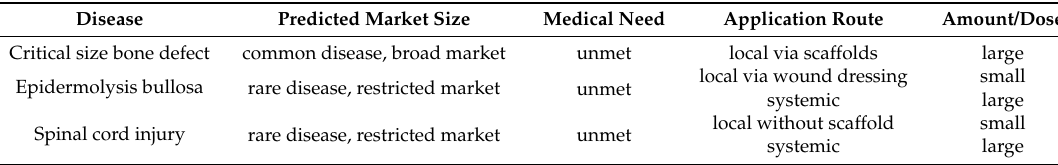
Table 2. Considerations for the manufacture of mesenchymal stromal cell-derived extracellular vesicles (MSC-EVs) for selected therapeutic applications. For any therapeutic application of MSC-EVs, we principally suggest manufacturing under xenogenic substance-free conditions, and under consideration of the pros and cons of allogeneic